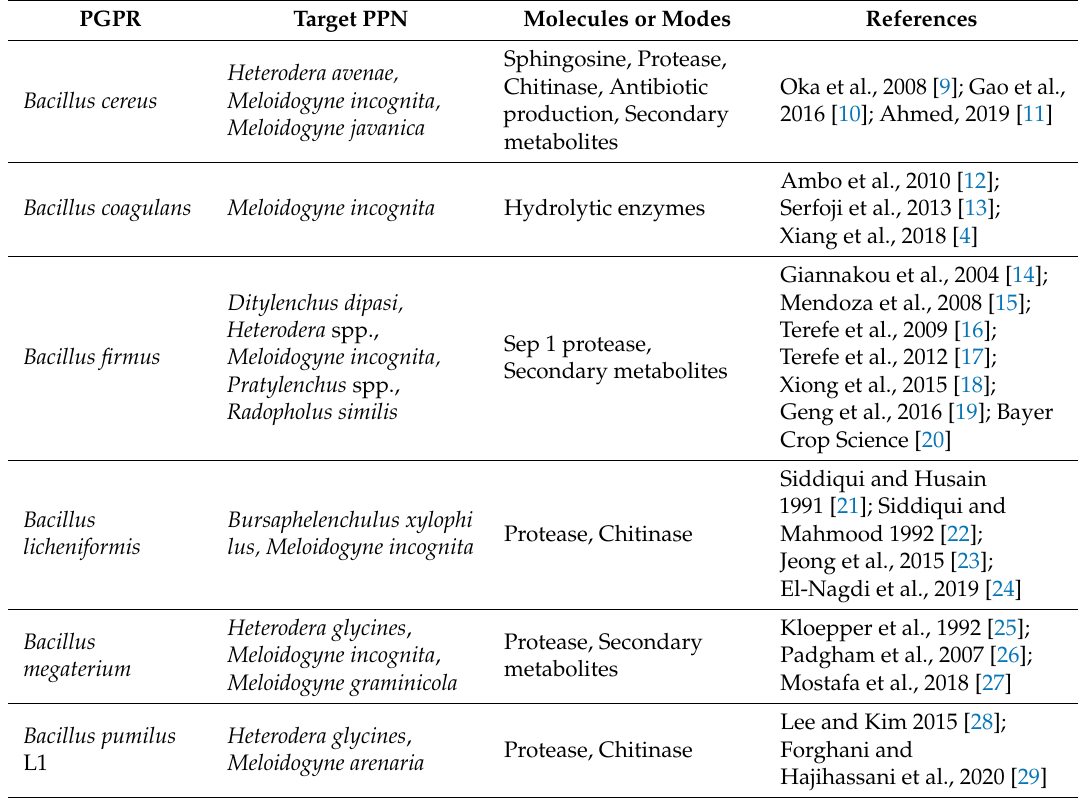
Table 1. A list of plant growth-promoting rhizobacteria (PGPR) conferring direct antagonisms against plant-parasitic nematodes (PPN). PGPR Target PPN Molecules or